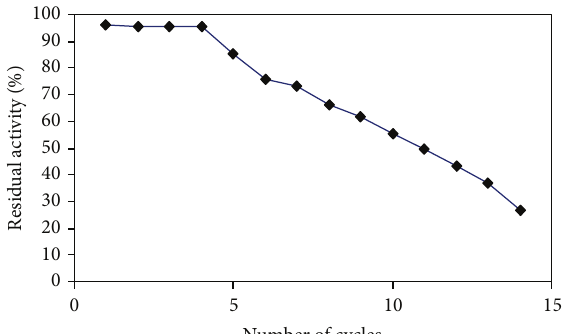
Figure 3: Operational stability of immobilized R. oryzae 3562 lipase for the synthesis of benzyl acetate.